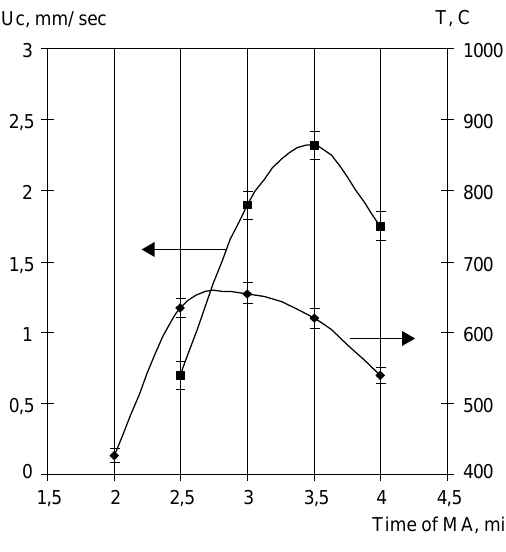
Fig. 12 Dependence of the combustion rate (U c ) and combustion temperature of the Ni 45 wt.% Ti mixture on the time of preliminary mechanical